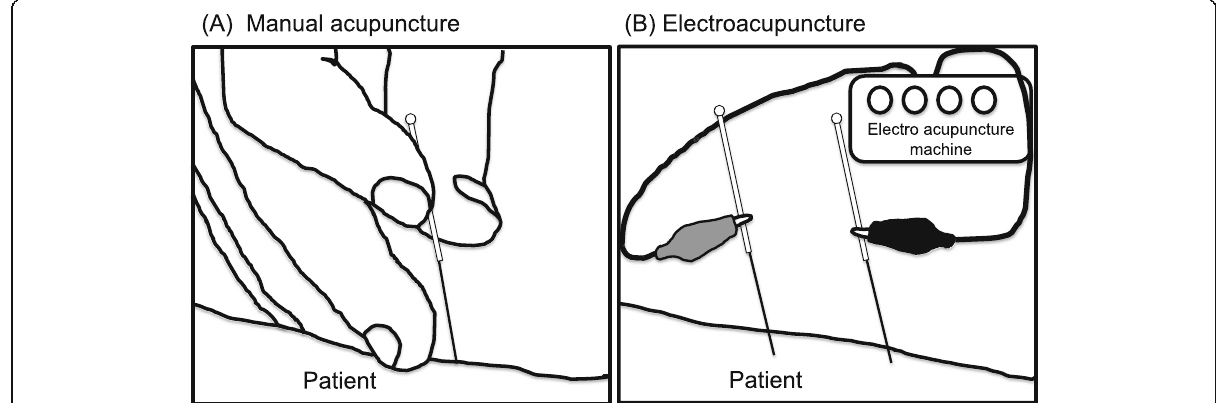
Fig. 2 Diagram of the two types of acupuncture treatment. a Manual acupuncture of traditional Chinese medicine type ( b )